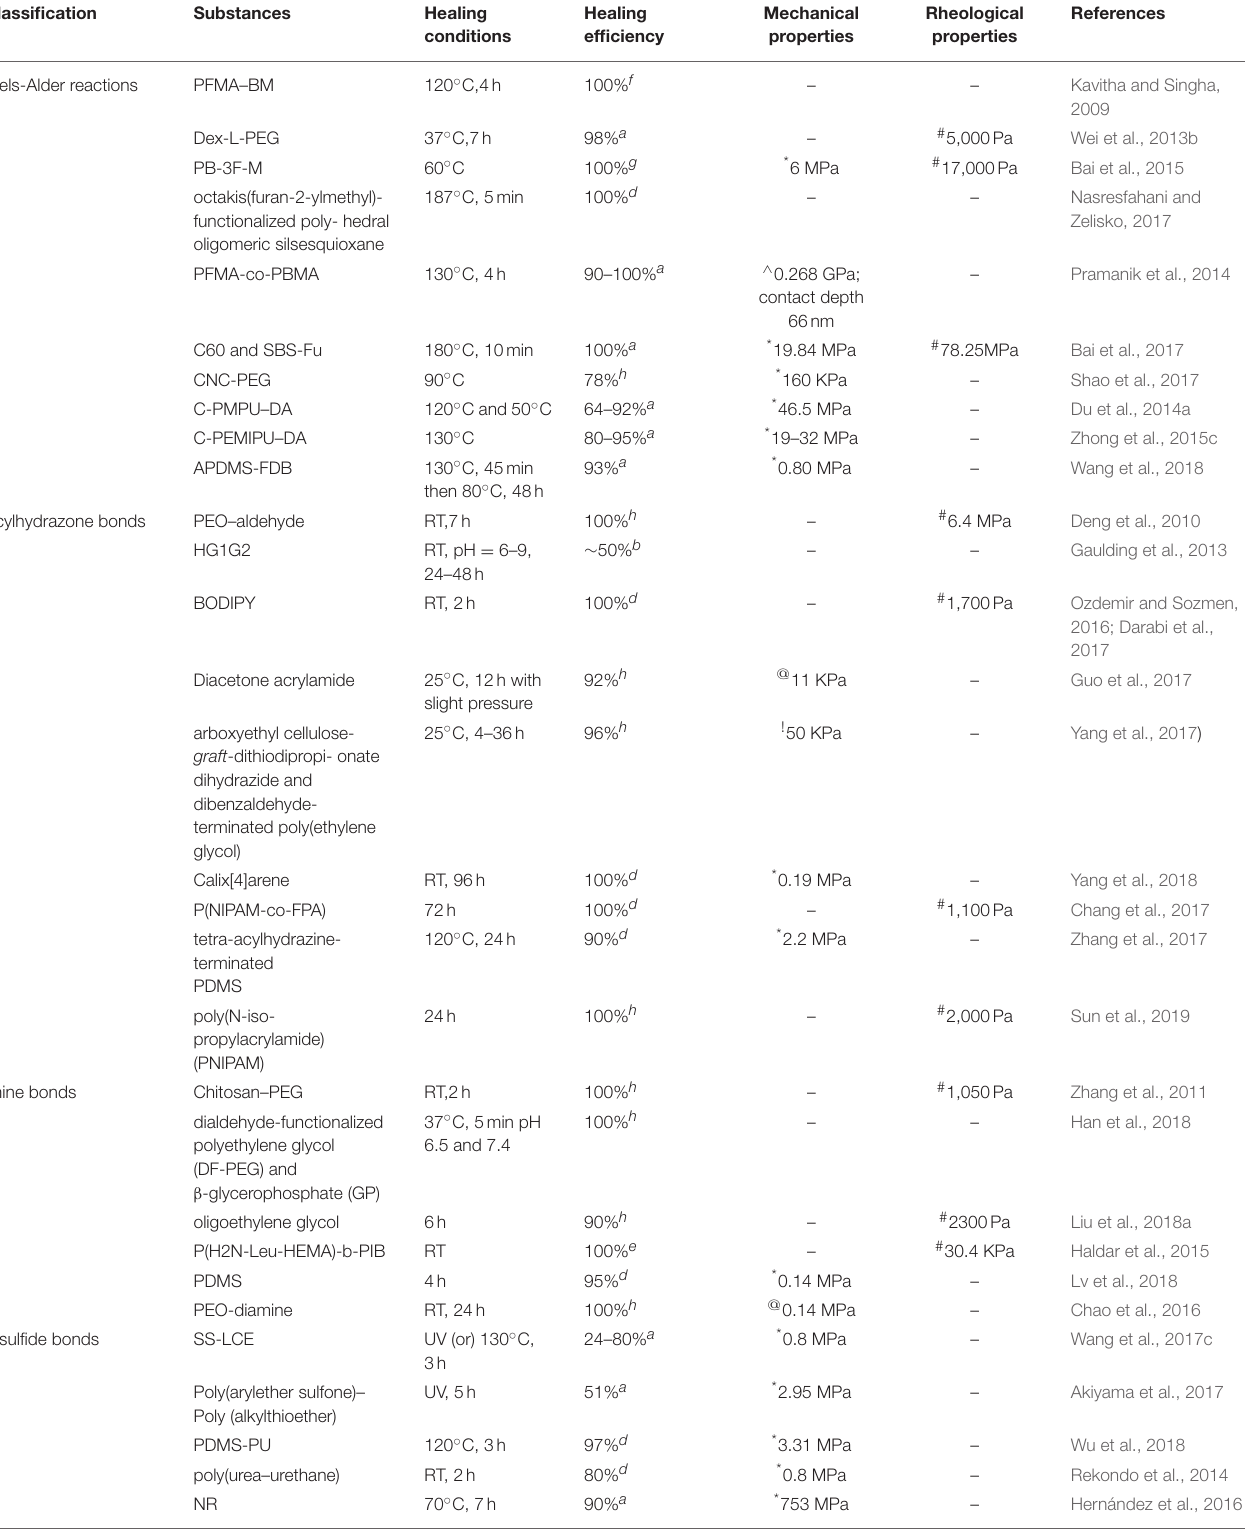
TABLE 3 | Examples of chemical interactions based soft self-healing